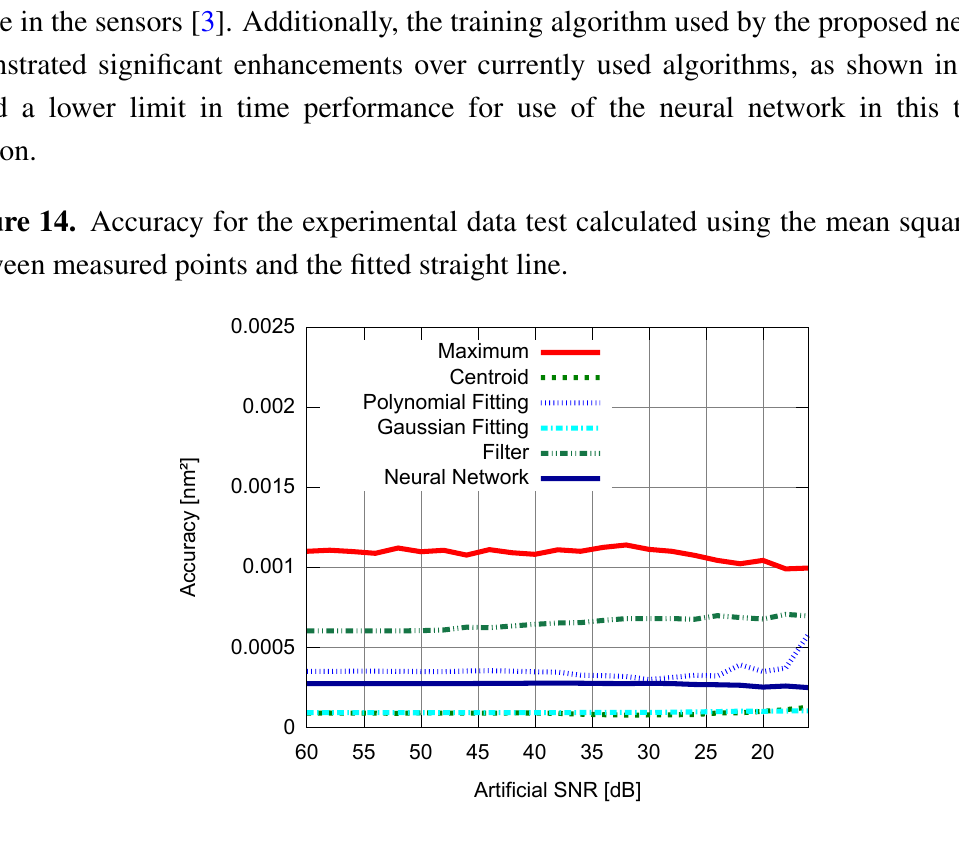
Figure 15. Precision for the experimental data test based on the square error standard deviation based on the measured points and the fitted straight